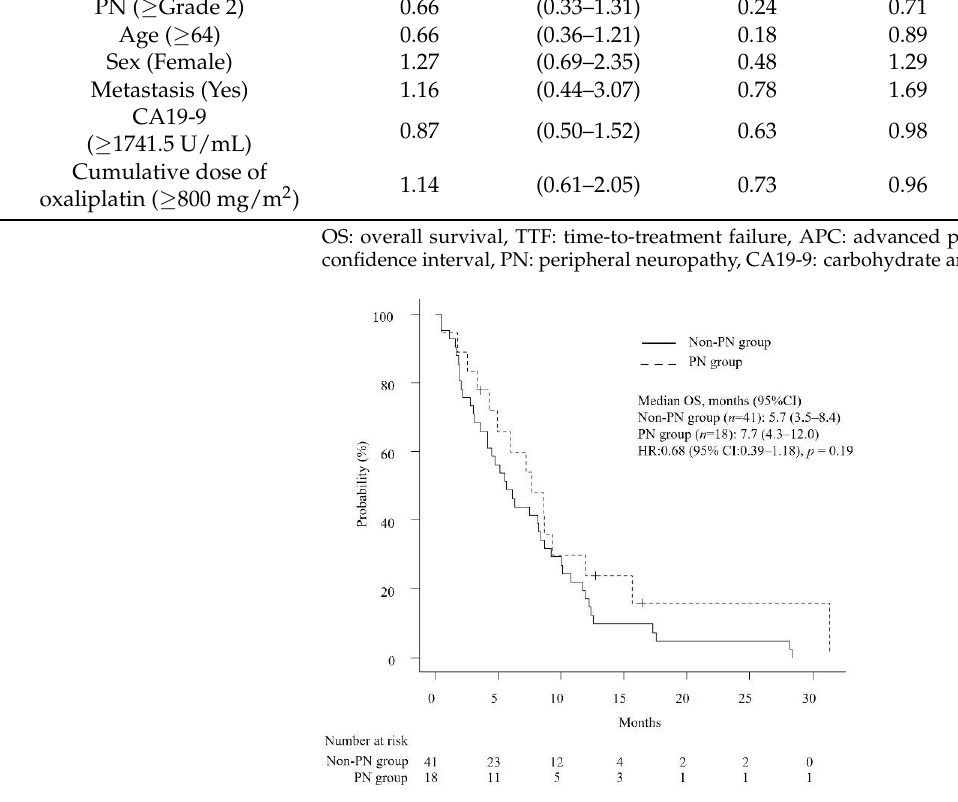
Figure 2. Kaplan – Meier curves comparing the overall survival of patients with unresectable APC Figure 2. Kaplan–Meier curves comparing the overall survival of patients with unresectable who received second-line GnP. PN : peripheral neuropathy, OS : overall survival, HR : hazard ratio.